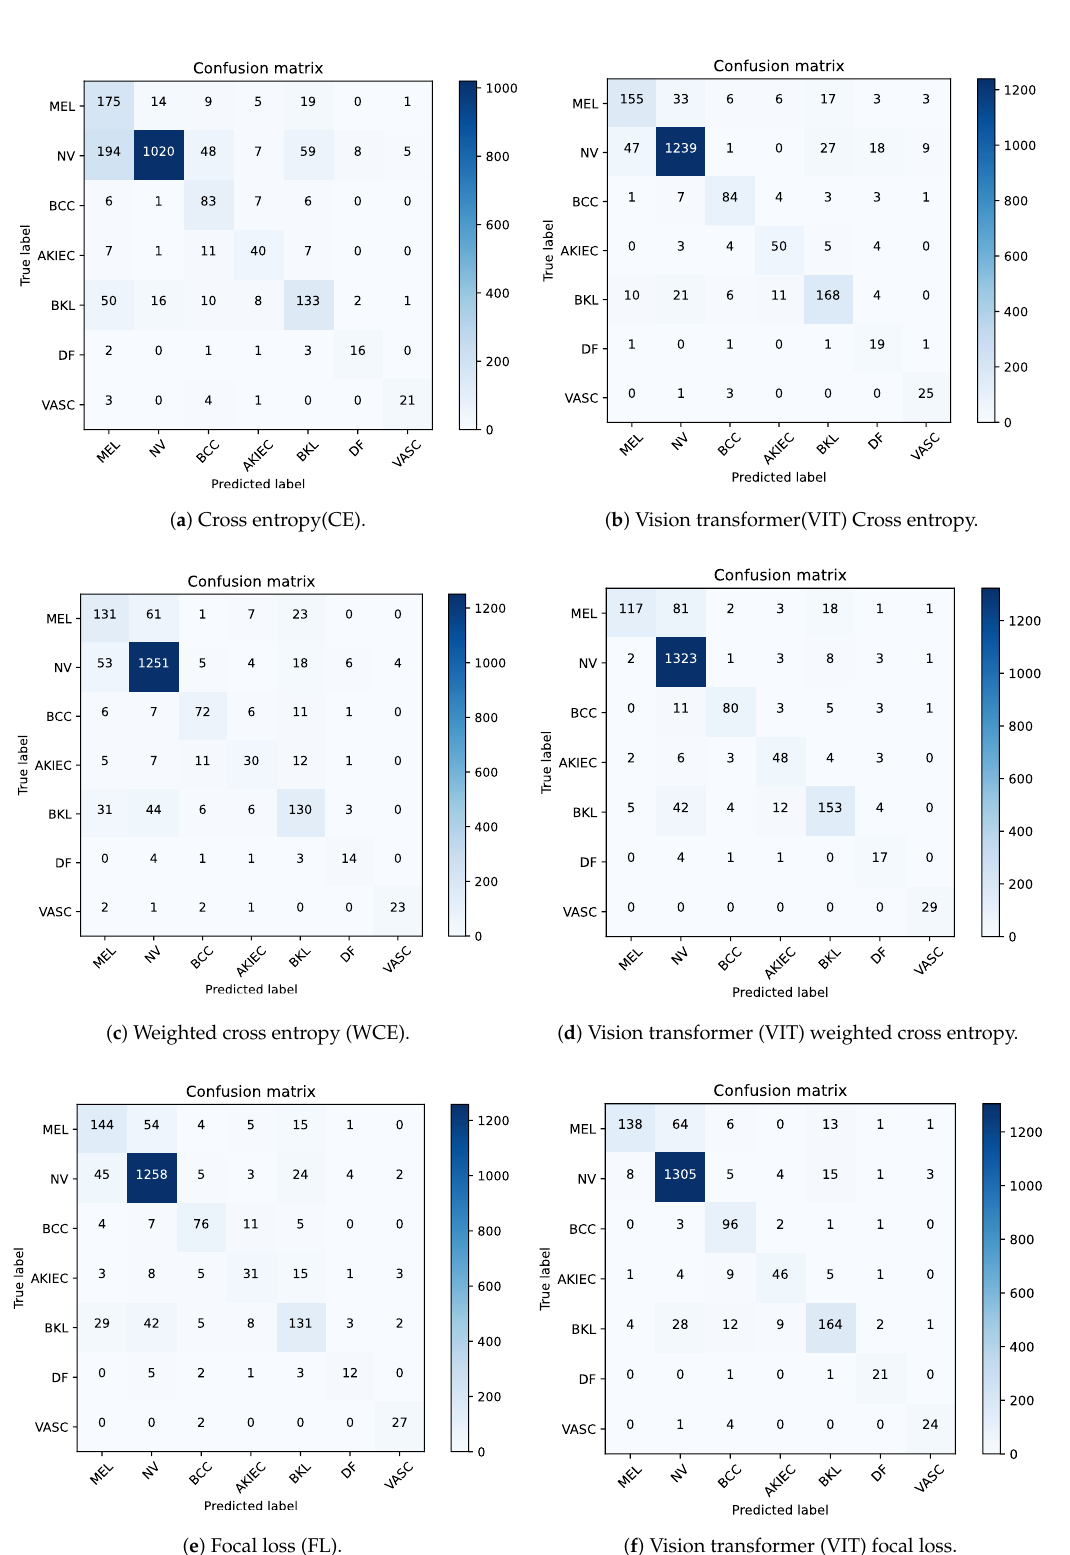
Figure 4. ( a – f ) Confusion matrix results of different methods used on the International Skin Imag- ing Collaboration (ISIC) 2018 dataset. AKIEC = actinic keratosis; BCC = basal cell carcinoma; BKL = benign keratosis lesion; DF = dermatofibroma; MEL = melanoma; NV = melanocytic ne- vus; VASC = vascular